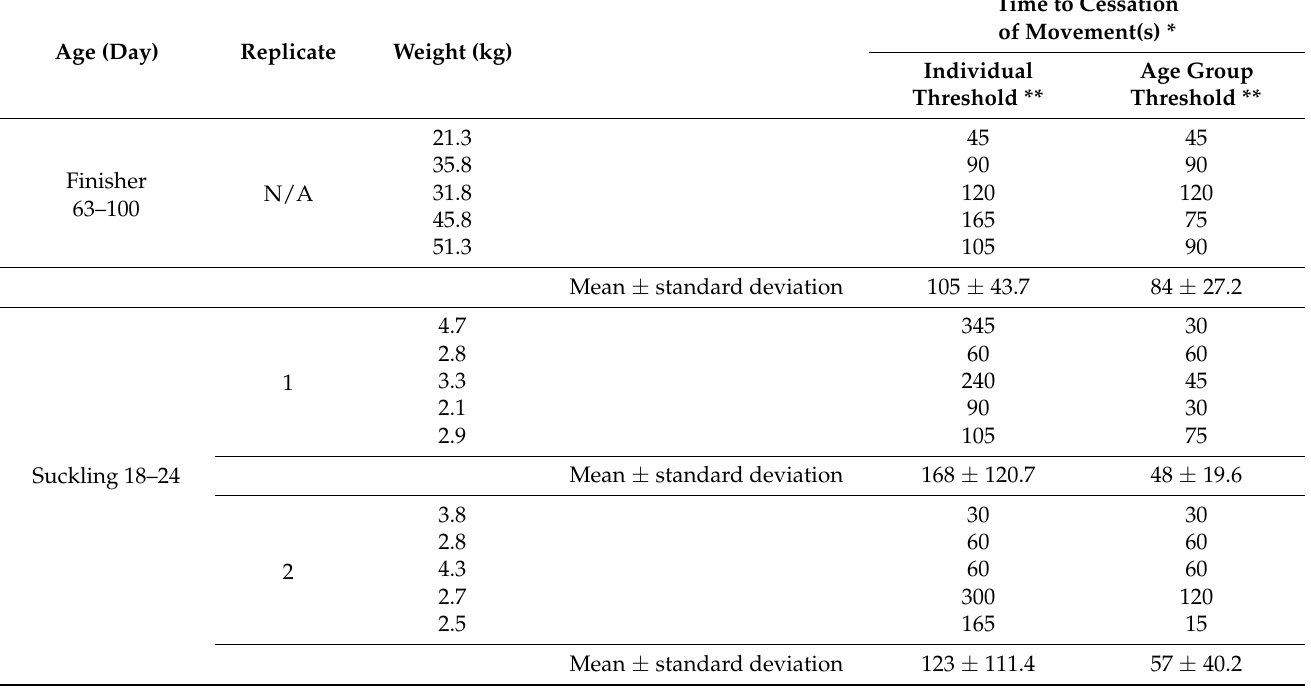
Table 1. Pig body-weight range or individual pig weight and time to cessation of movement (COM) post-foam initiation for conscious, logger-implanted finisher and suckling pigs evaluated in water- based foam depopulation